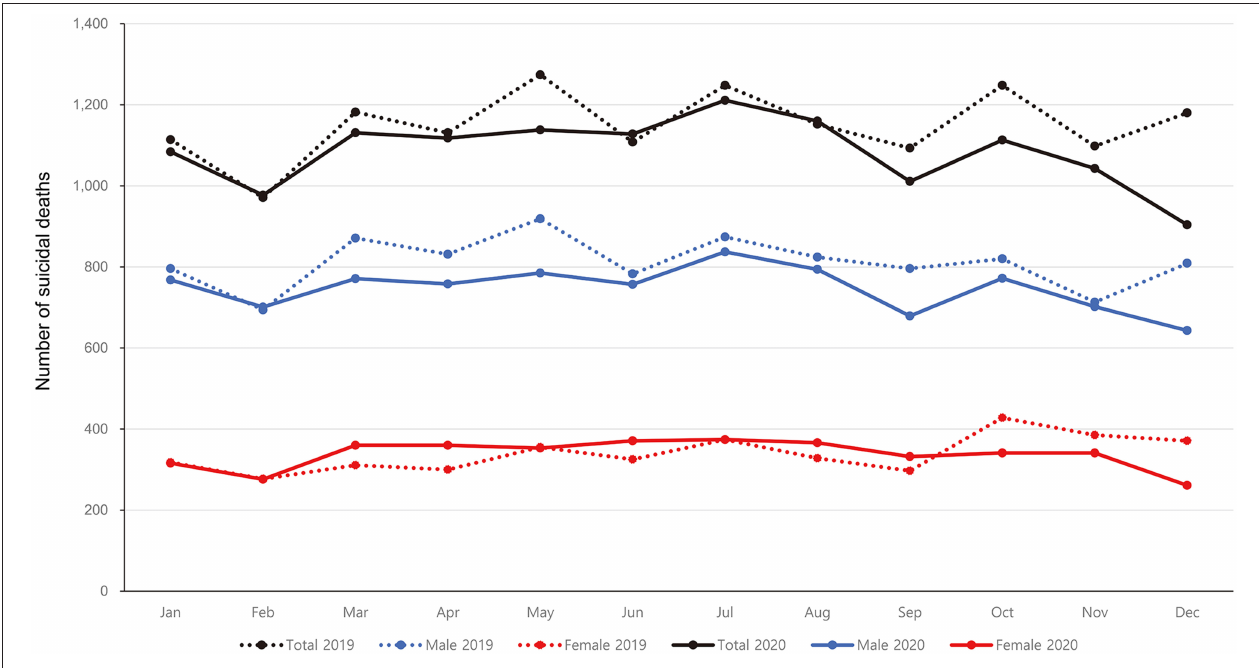
FIGURE 2 | Number of suicidal deaths in South Korea (provisional